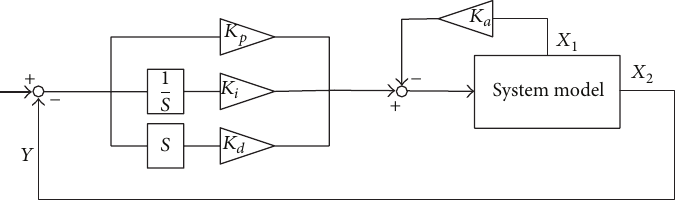
Figure 2: General structure of control system.